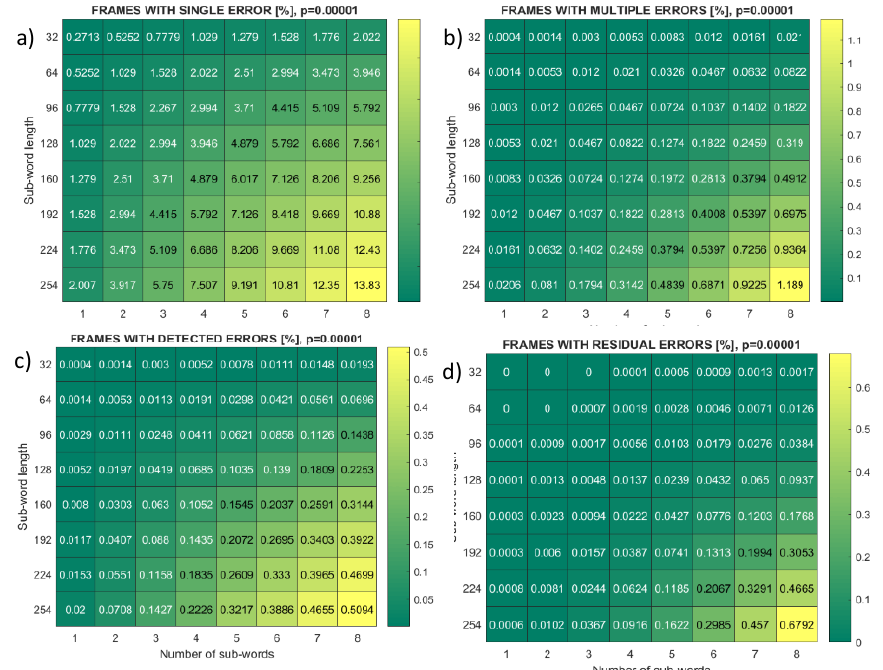
Figure 8. Heat maps of frame error events, symbol length m = 8, bit error rate p = 10 −5 , for different fragments (sub-words) number and length. ( a ) Single error; ( b ) multiple errors; ( c ) detected errors; ( d ) missed (residual) errors.